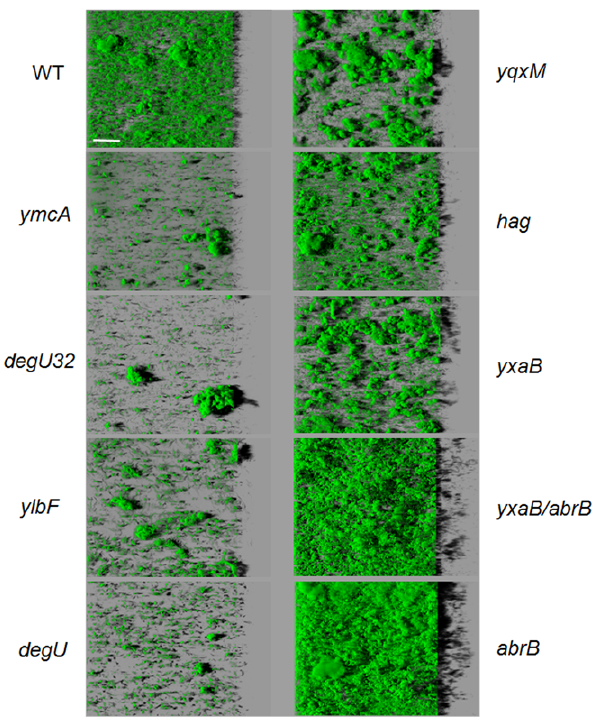
Figure 5. Effect of mutations on the three-dimensional structure of biofilms. Effects of mutations on immersed biofilm structures of the biofilms obtained with different GFP-carrying mutant strains and the corresponding reference wild-type (WT) strain from the confocal image series using the IMARIS software. Images depict an aerial view of 48h-biofilms in the microplate system. The scale bar is 50 m m.